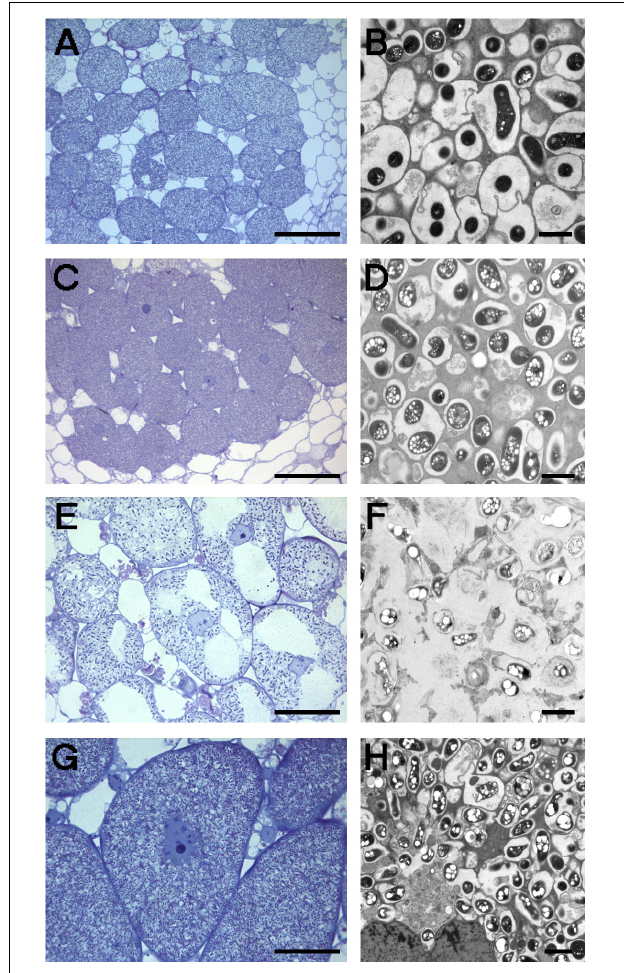
FIGURE 4 | Optical (A,C,E,G) and electronic (B,D,F,H) microscopy of nodules induced by different S. fredii strains in G. soja CH4. (A,B) HH103 Rif R ; (C,D) NGR234; (E,F) NGR234C pSymHH103M; (G,H) USDA193C pSymNGR234M. Bars correspond to 100 µ m in (A,C) , 30 µ m in (E,G) , and 2 µ m in (B,D,F,H)